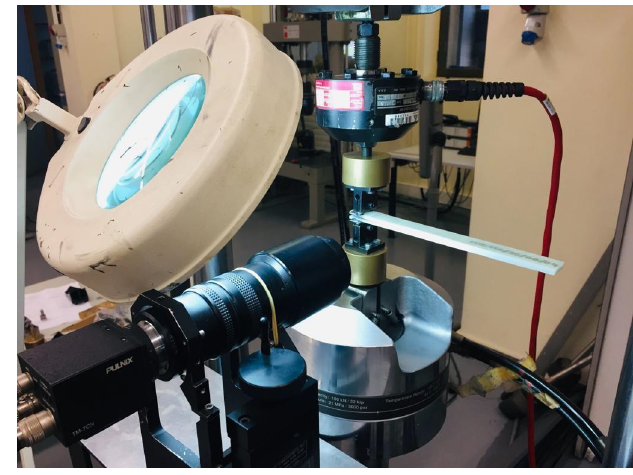
Figure 3. Specimen arrangement on test equipment.